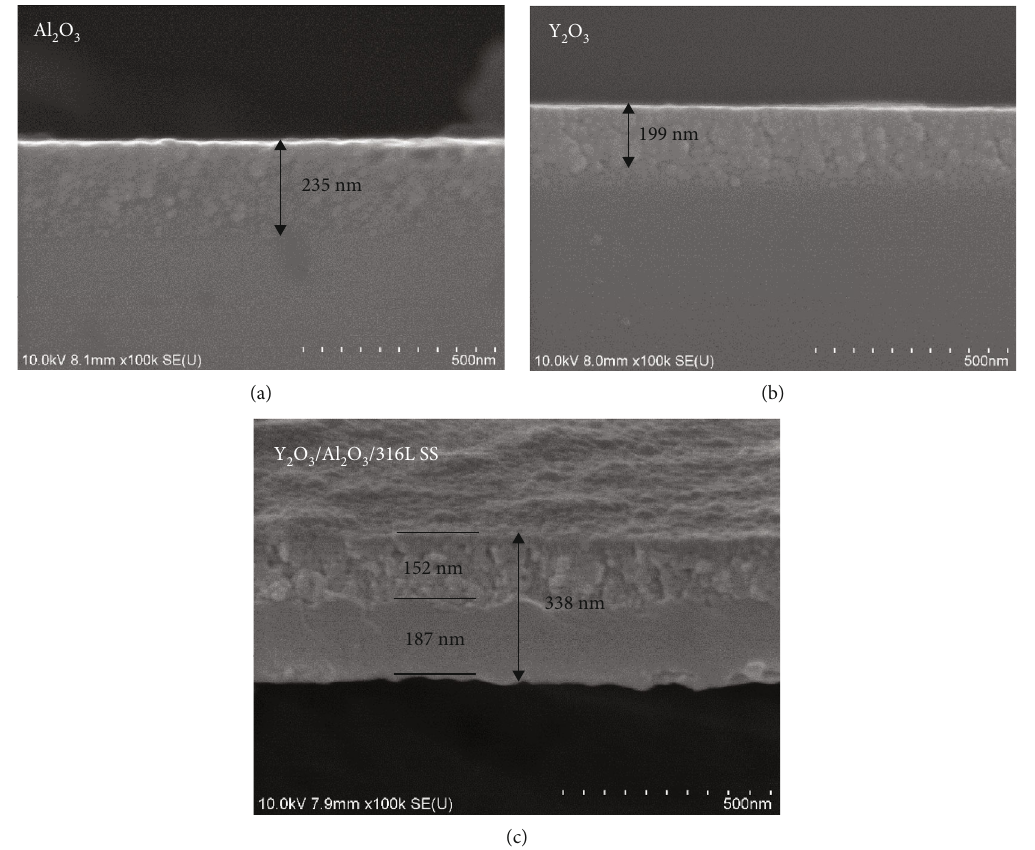
Figure 1: SEM images of the nanoscale coatings [21]: (a) Al